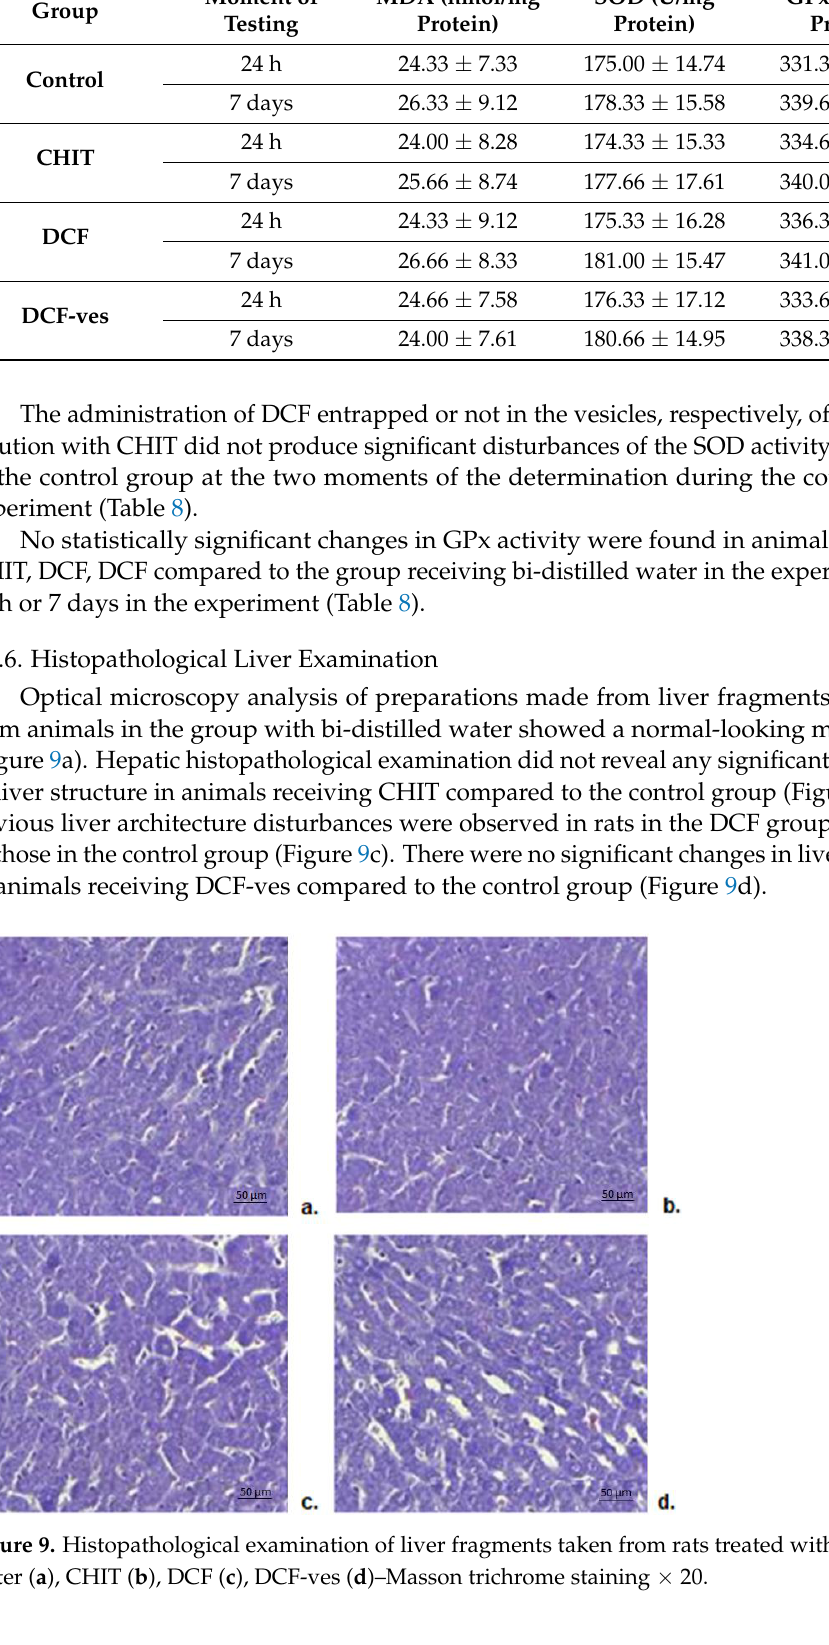
Table 8. Serum levels of MDA, SOD and GPx in animals treated with CHIT, DCF and DCF-ves. Values are expressed as the arithmetic mean ± S.D. of the average values for 6 animals per group.